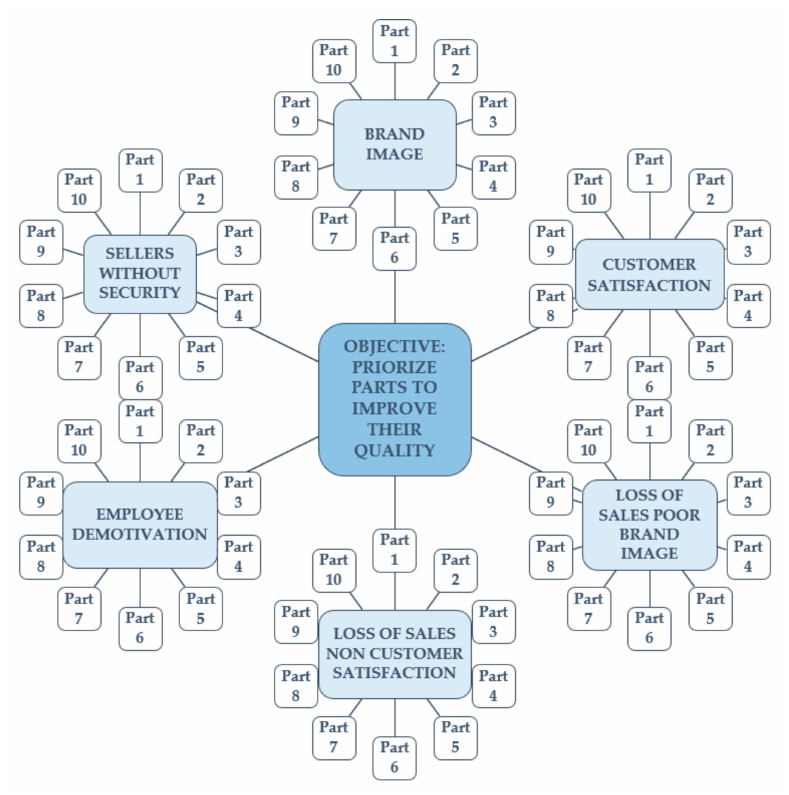
Figure 2. Hierarchy scheme of the AHP